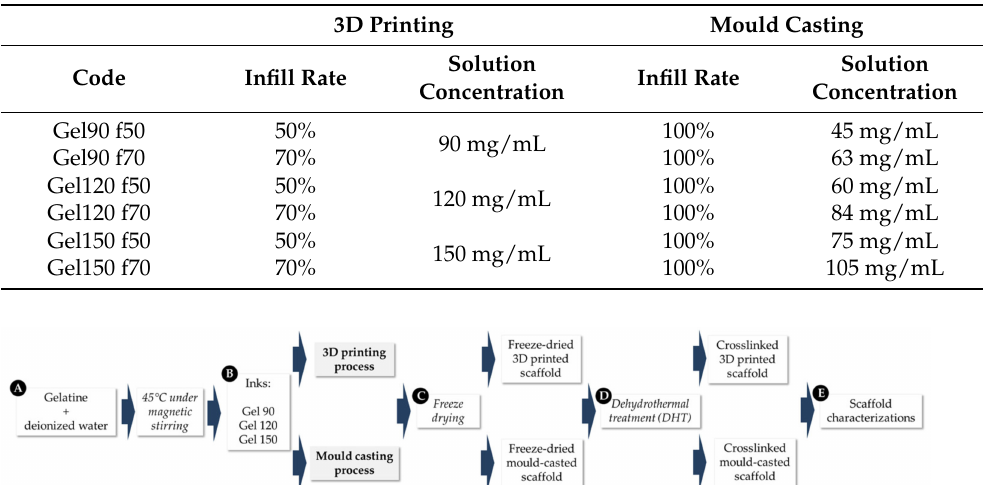
Table 1. Gel solution concentrations for the realization, respectively, of the 3D-printed and mould- casted scaffolds. The mould casting solutions were adapted considering the 3D-printed scaffolds’ infill